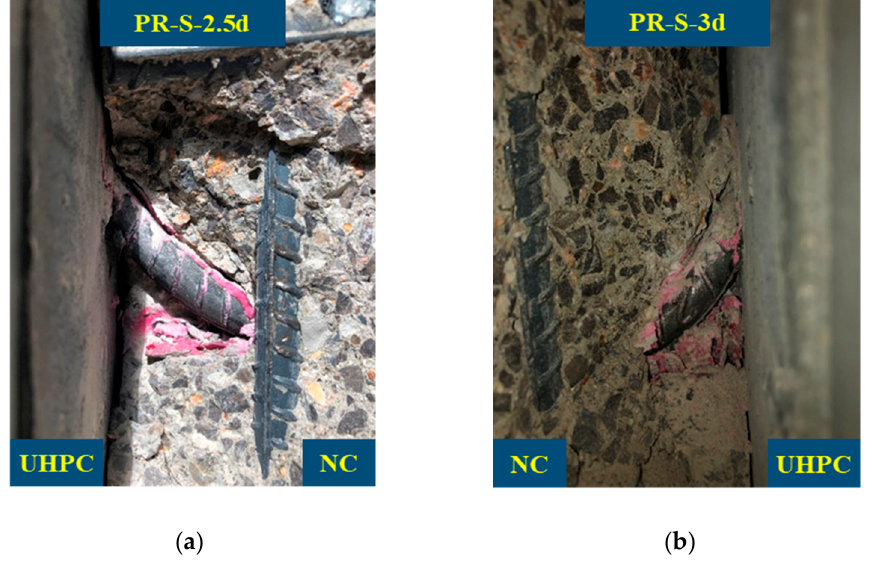
Figure 6. Details of NC crush . ( a ) PR-S-2.5d-1; ( b ) PR-S-3d-2.